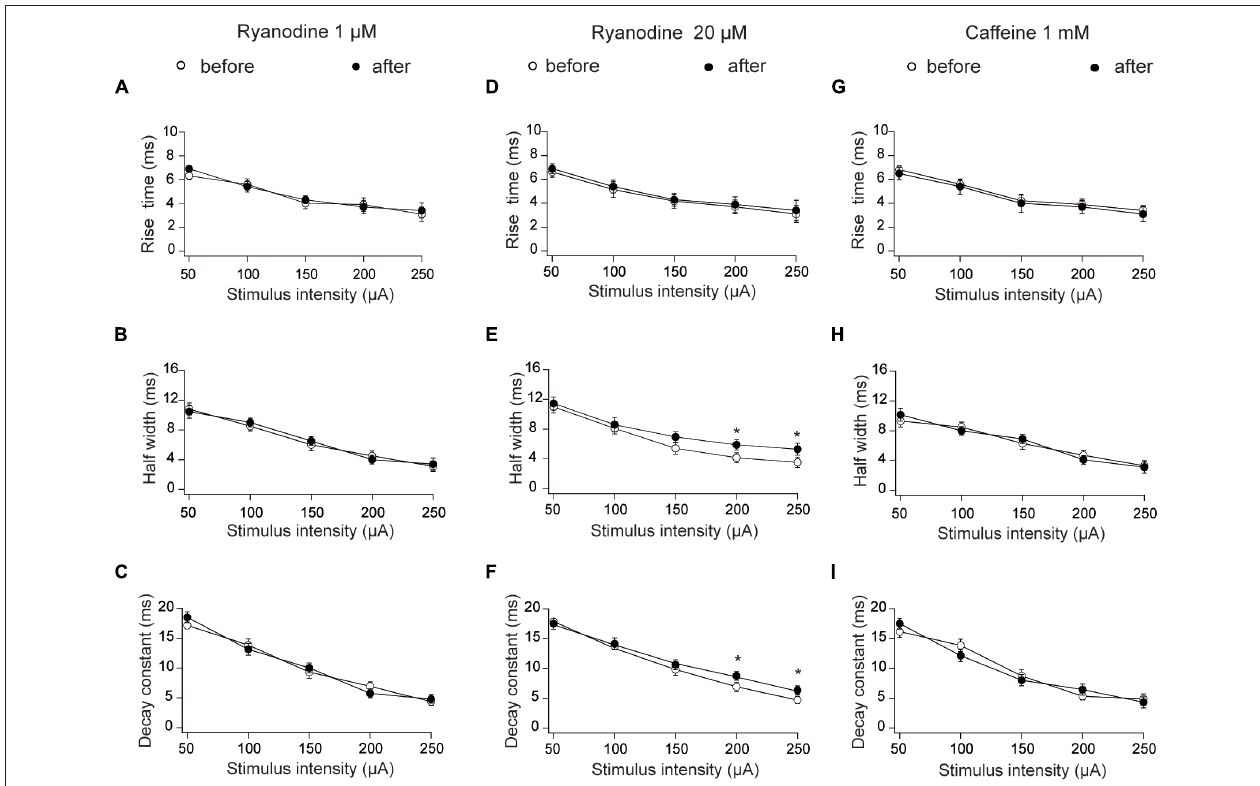
FIGURE 2 | Effects of stimulatory and inhibitory ryanodine concentrations and of caffeine on fEPSP rise times, half-widths and decay constants tau measured in CA3–CA1 hippocampal synapses. Left panels: slices were treated with 1 µ M ryanodine. (A) fEPSP rise times vs. stimulus intensity. (B) fEPSP half-widths vs. stimulus intensity; (C) fEPSP decay constants (tau) vs. stimulus intensity. Central panels: slices were treated with 20 µ M ryanodine for 60 min. (D) fEPSP rise times vs. stimulus intensity; (E) fEPSP half-widths vs. stimulus intensity; (F) fEPSP decay constants (tau) vs. stimulus intensity. Right panels: slices were treated for 15 min with 1 mM caffeine. (G) fEPSP rise times vs. stimulus intensity; (H) fEPSP half-widths vs. stimulus intensity; (I) fEPSP decay constants (tau) vs. stimulus intensity. Values represent Mean ± SE; (12, 3). The first number in parentheses indicates the number of hippocampal slices and the second the number of animals used. Statistical significance of values was assessed Mann-Whitney test ( ∗ p <